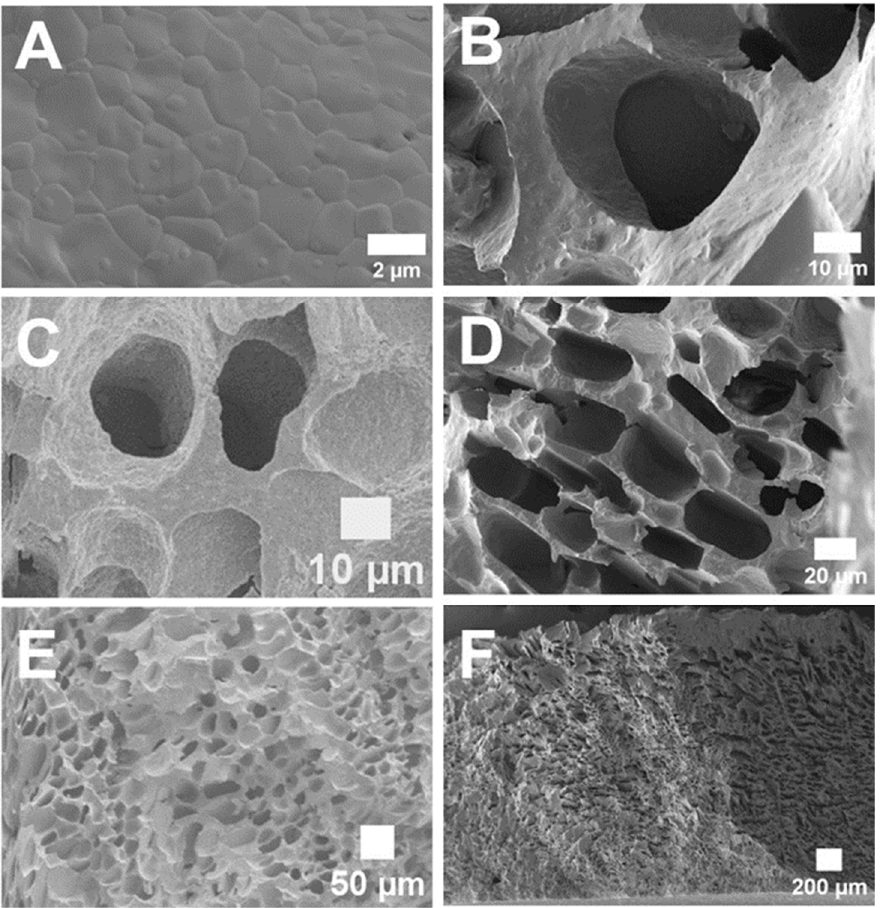
Figure 2. ( A ) The microstructure of the porous YSZ sintered at 1450 °C for 4 h. ( B ) A magnified image of pores at transversely fractured plane. ( C ) A magnified image of pores at longitudinally fractured plane. ( D ) An image of spherical pores and tubular pores. ( E , F ) Lower magnification images of the pore morphology at a fractured surface.